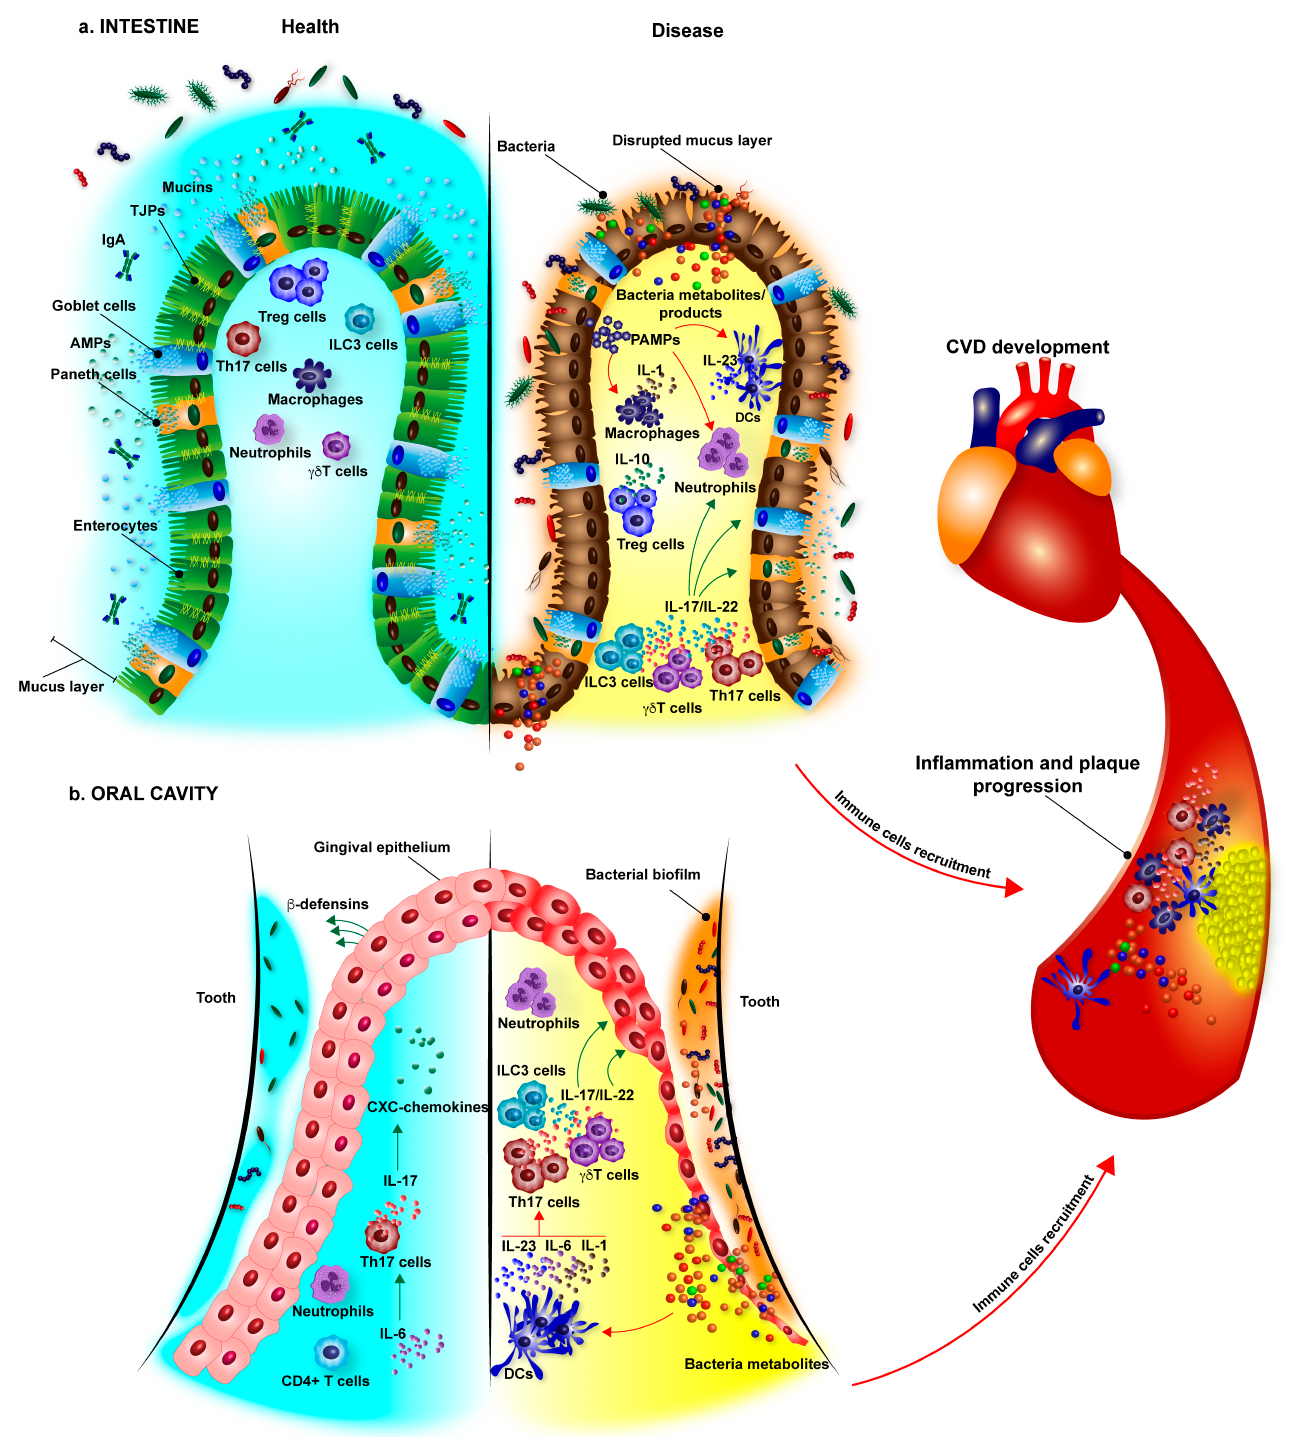
Figure 1. Mucosal barrier in health and disease: implication to atherosclerosis. ( a ) The barrier in the intestine consists of the intestinal epithelium; a mucus layer, which is composed of mucins and other structural proteins; antimicrobial peptides (AMPs) and IgA molecules, which bind to microbes and reduce their mobility in the mucus; and resident and infiltrating immune cells. Left. The function of intestinal epithelial cells, tight junction proteins (TJPs), antimicrobial peptide expression, and IgA translocation is tightly regulated by cytokine signaling that is important for the control of intestinal permeability and bacteria or bacteria-derived product translocation. A large number of immune cells (Treg cells, neutrophils, macrophages, Th17 cells, γδ T cells, ILC3) are present in the normal gut lamina propria to maintain tissue integrity and produce cytokines, which regulate the anti-microbial response. Reciprocal regulation between microbiota and cytokines, i.e., the microbiota composition controls the production of cytokines, while cytokines regulate intestinal epithelial